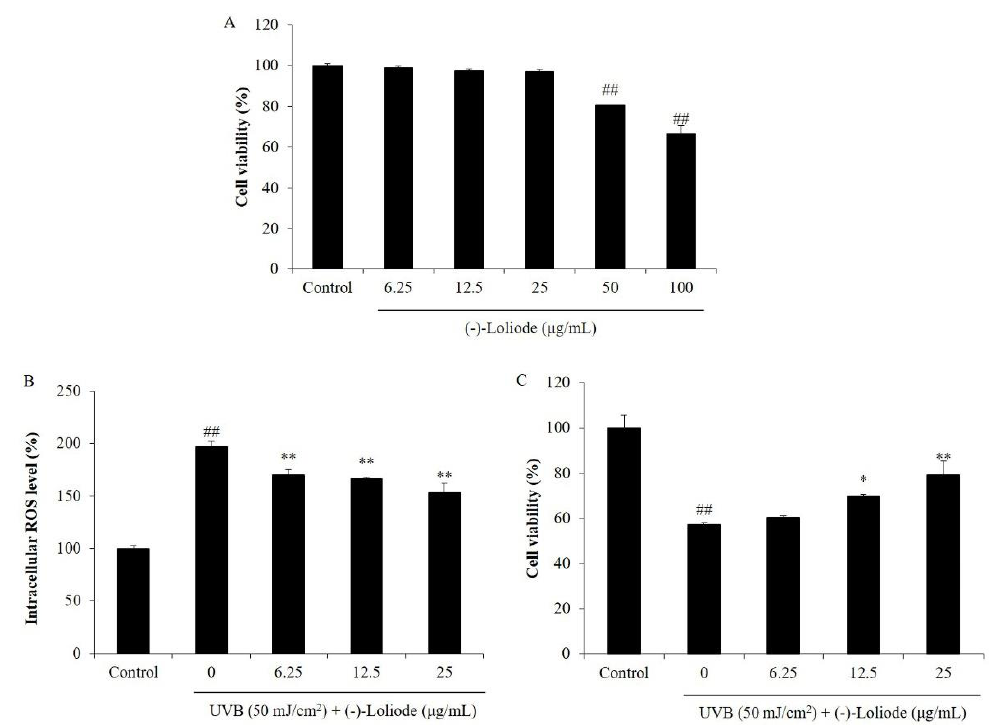
Figure 4. Protective effect of (-)-loliode against UVB-induced HDF cells damage. ( A ) Cytotoxicity of (-)-loliode on HDF cells; ( B ) intracellular ROS scavenging effect of (-)-loliode in UVB-irradiated HDF cells; ( C ) protective effect of (-)-loliode on UVB-induced cell death in HDF cells. Cell viability was measured by the MTT assay and intracellular ROS level was measured by the DCF-DA assay. The data were expressed as the mean ± SE (n = 3). * p < 0.05 and ** p < 0.01 as compared to the UVB-irradiated group, and ## p < 0.01 as compared to the control group.